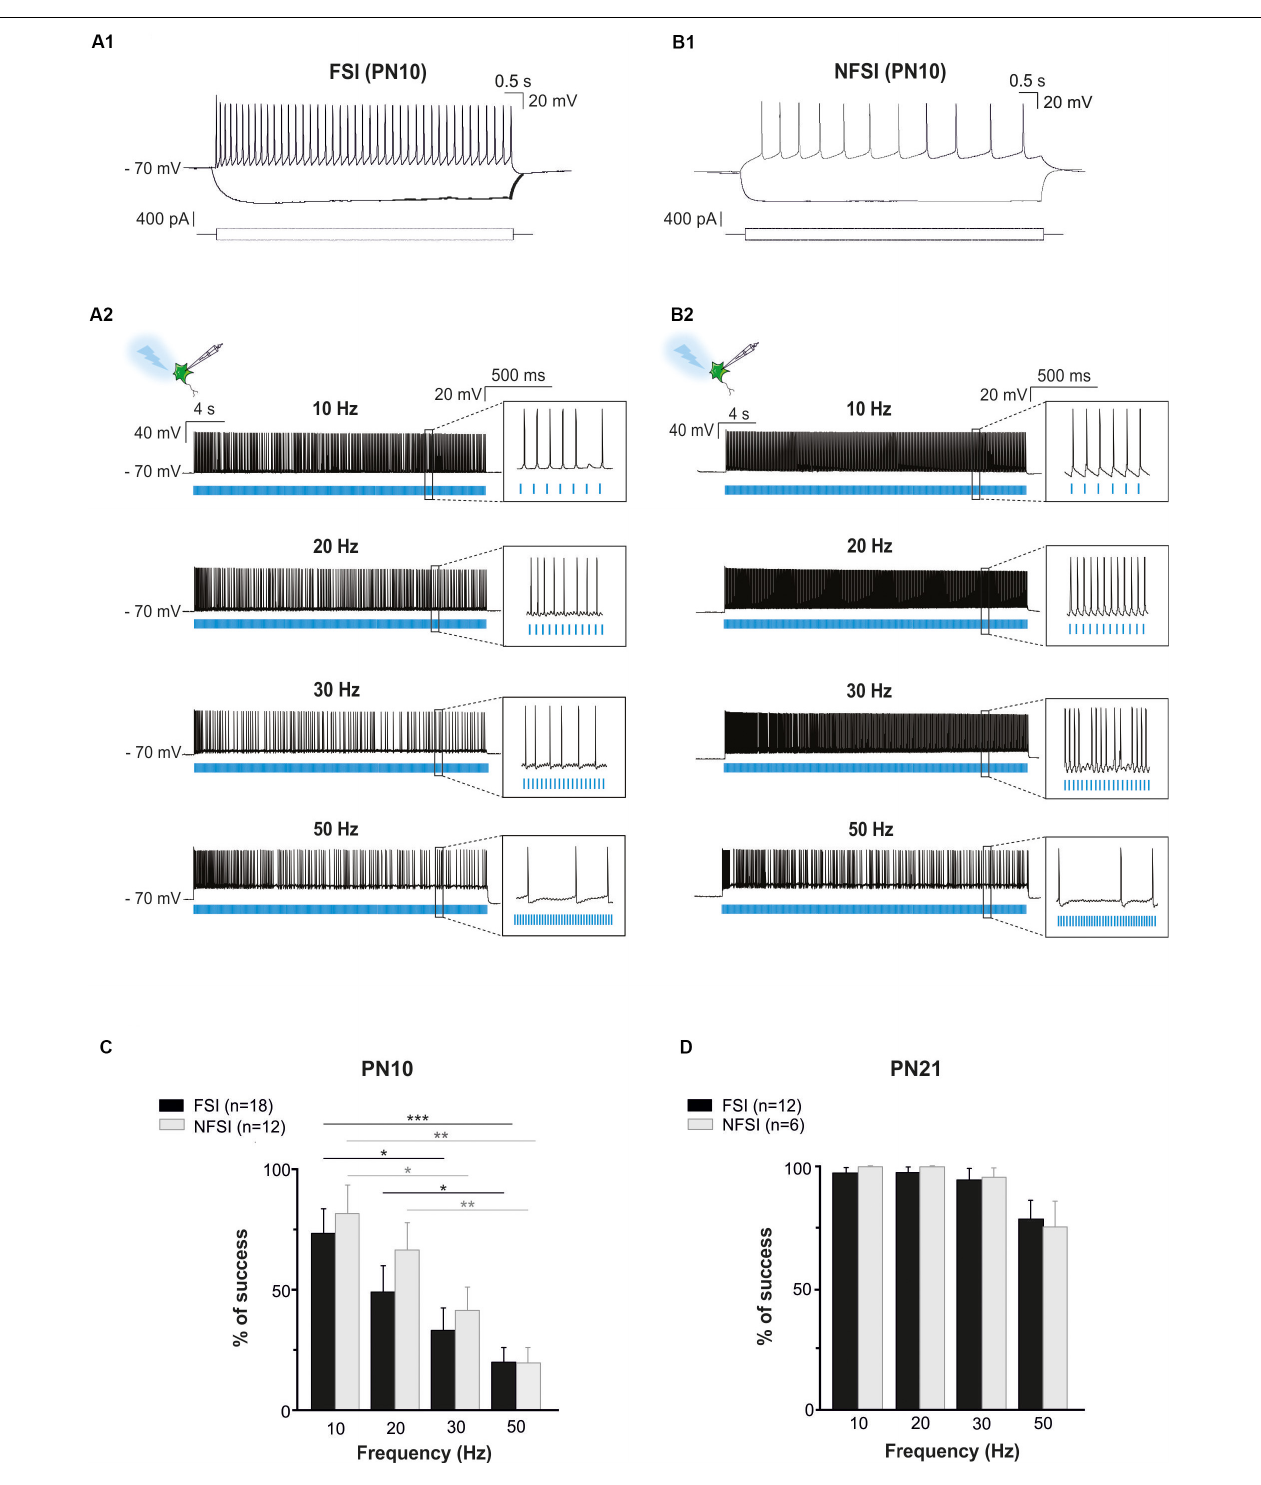
FIGURE 2 | Photoactivation of ChR2-expressing FSI and NFSI in PN10 Nkx2.1 Cre :ChR2-YFP Lox / + mouse pups in brain slices. (A1,B1) Current-clamp recordings of a FSI (A1) and a NFSI (B1) expressing ChR2 in cortical layer V at PN10. Note the differences of firing properties between the two cells in response to 800 ms depolarizing and hyperpolarizing steps (bottom square pulses). (A2,B2) The same FSI (A2) and NFSI (B2) were photostimulated (blue bars) with 10 ms light pulses during 30 s at different frequencies. (C,D) Average percentage of success to elicit action potentials with light trains at different photostimulation frequencies for FSI (black) and NFSI (gray) at PN10 (C) and PN21 (D) . ∗ p < 0.05; ∗∗ p < 0.01; and ∗∗∗ p < 0.001 for comparisons across each interneuron subtype, Kruskal–Wallis Test followed by a Dunn’s post hoc Test; not significant differences ( p > 0.05) between FSI and NFSI for each frequency are not indicated; Mann–Whitney test.